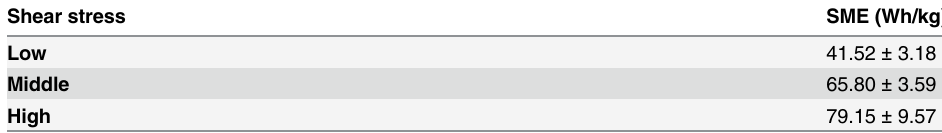
Table 3. Specific mechanical energy (SME) of each shear stress condition.